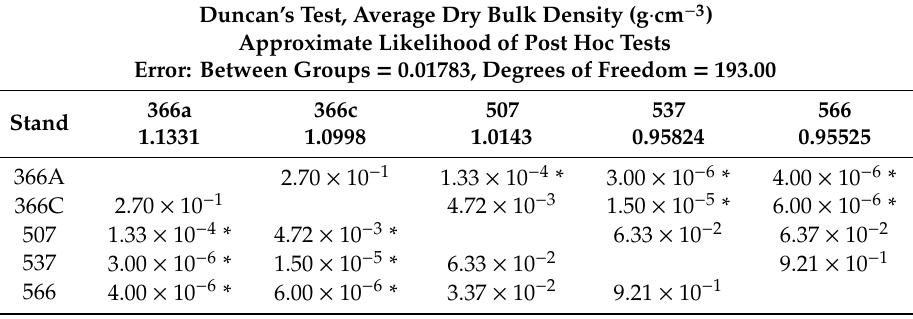
Table 8. Duncan’s test of soil bulk density in